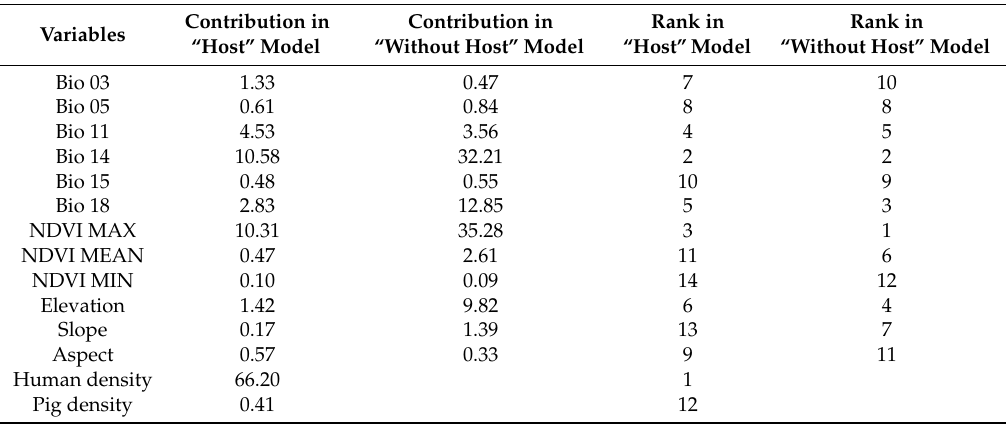
Table 3. The percent contribution of each variable in two models.